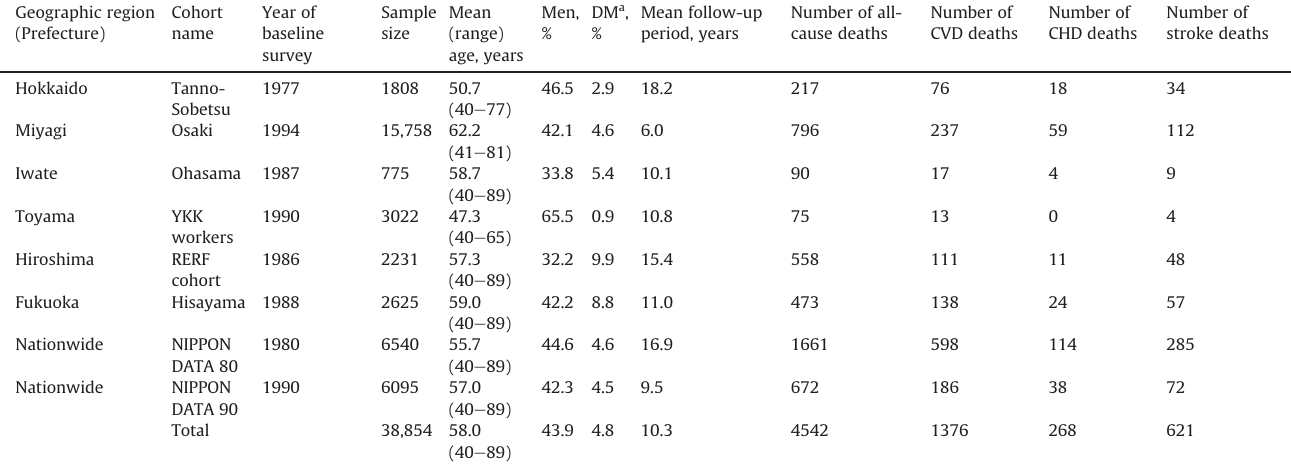
Table 1 Characteristics of included